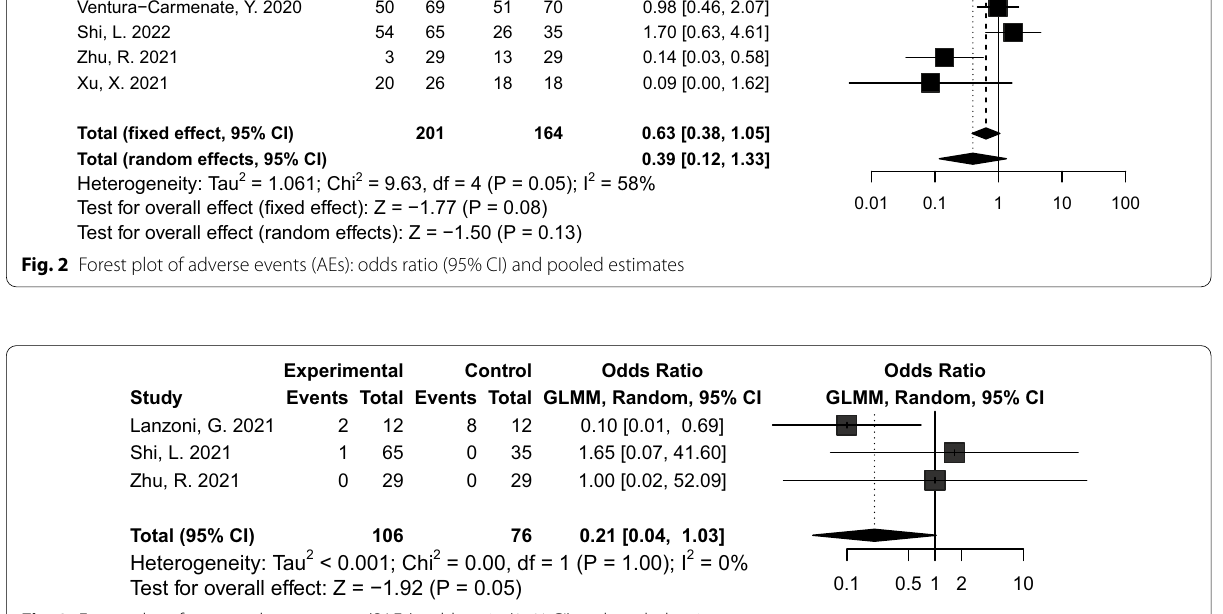
Fig. 3 Forest plot of severe adverse events (SAEs): odds ratio (95% CI) and pooled